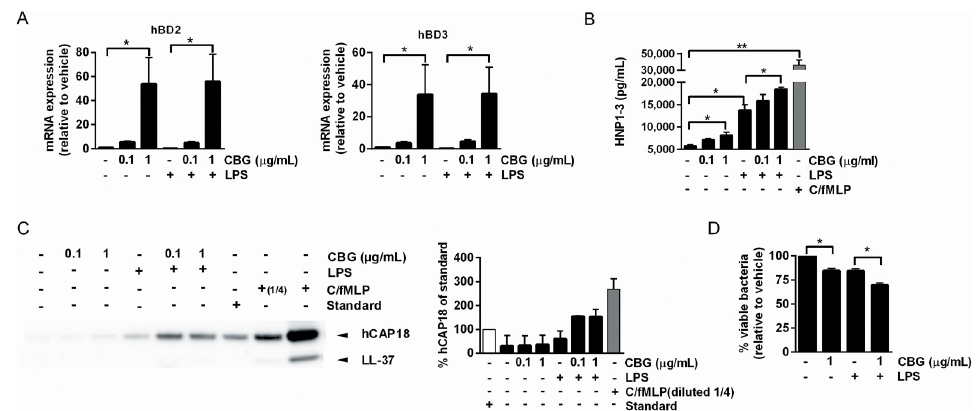
Fig 5. Induction of AMPs in DCs and neutrophils. (A) DCs were stimulated with vehicle or CBG in the absence or presence of LPS for 24 hours. Quantitative polymerase chain reaction (qPCR) for hBD-2 and hBD- 3, normalized to GAPDH, was performed, and data shown represent mean gene expression (fold change compared to vehicle) + SEM for 3 donors. (B-D) Neutrophils were stimulated with vehicle or CBG in